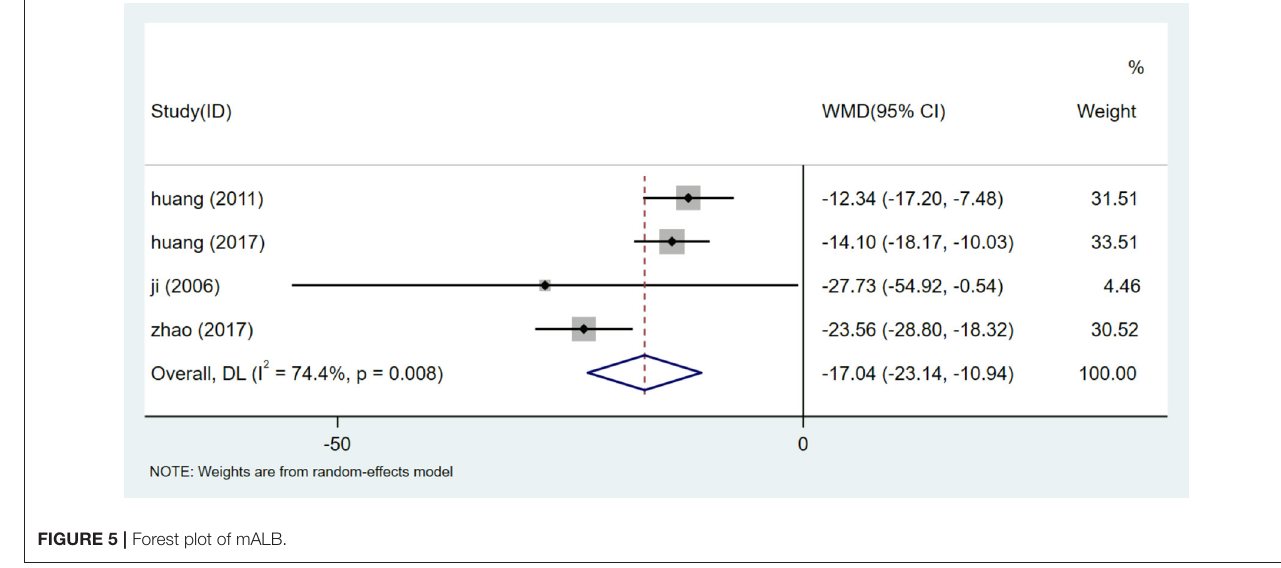
FIGURE 5 | Forest plot of mALB.